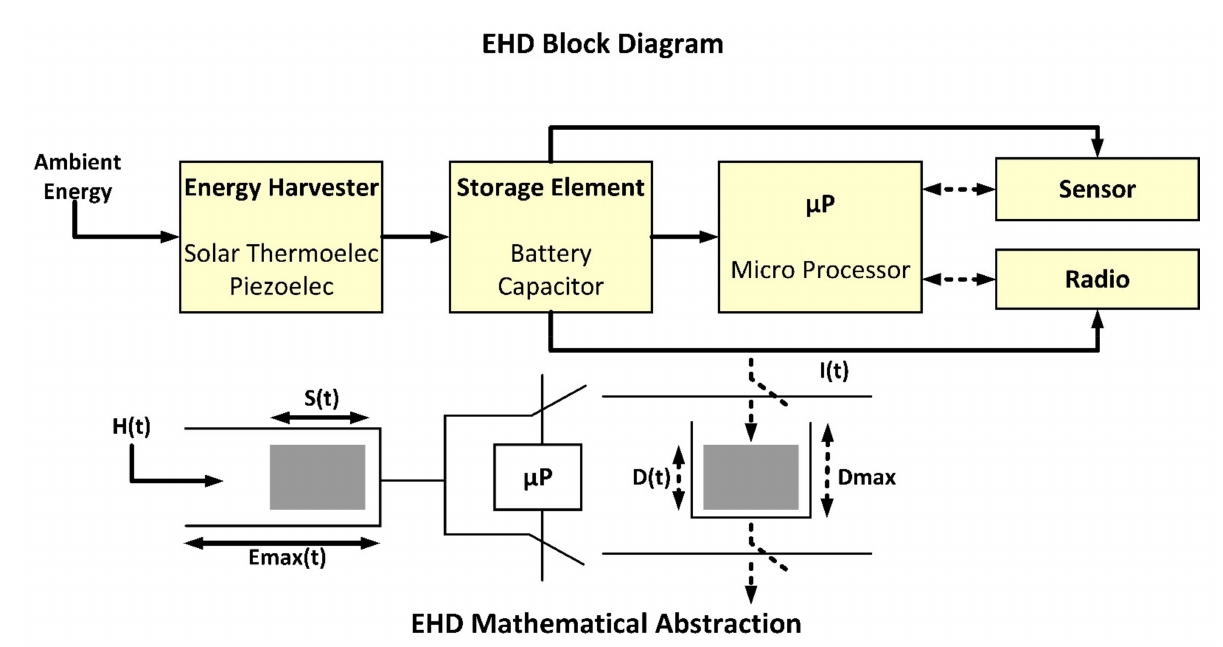
Figure 1. Block diagram of an energy harvesting device with mathematical abstraction